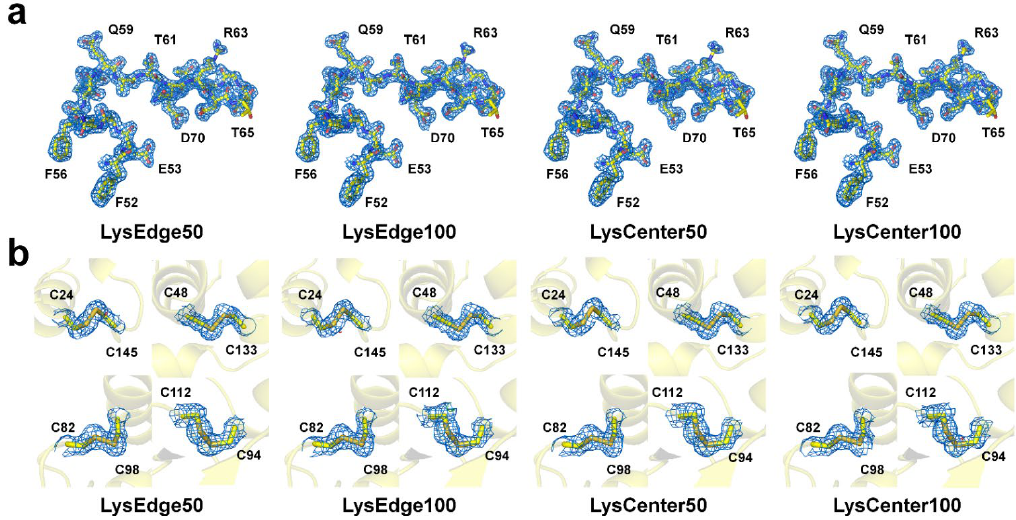
Figure 3. Structures of lysozymes at room temperature using pink-beam SSX. ( a ) 2mFo-DFc (marine mesh, 1.0 σ) of the active site and substrate binding cleft of lysozyme. ( b ) 2mFo-DFc (marine mesh, 1.0 σ) and mFo - DFc (green mesh 3.0 σ, and red mesh −3.0 σ) electron density maps for the disulfide bonds (C24–C145, C48–C133, C82–C98, and C94–C112) of lysozyme.